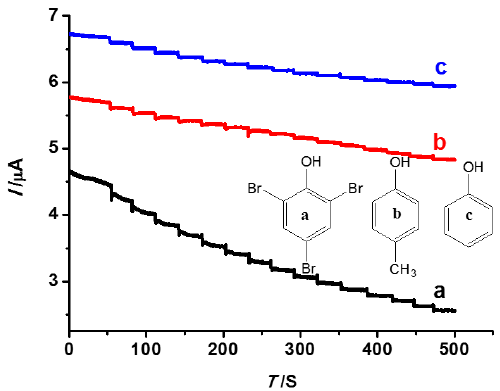
Figure 10. AC of the INS to different substances ( a : TBP; b : 4-methyl-phenol; and c : phenol).